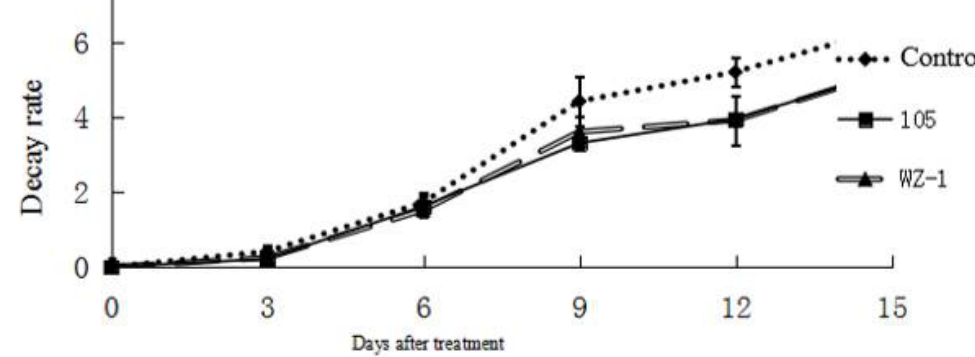
Figure 7. Effects of different treatments on weight-loss rate of tomato.